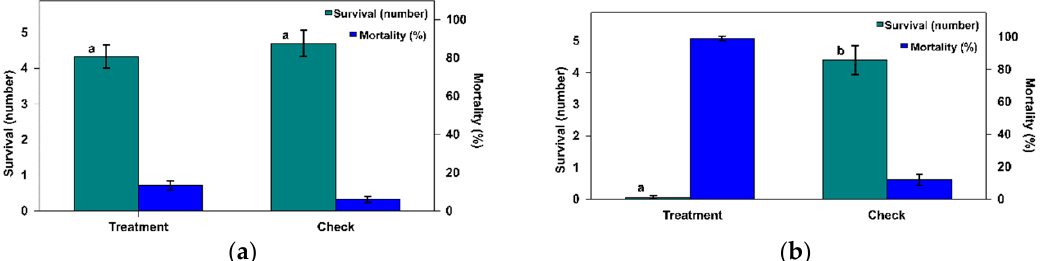
Figure 1. Number (±SE) of survivors and the mortality rate of Phthorimaea operculella eggs when exposed for 48 hours to an adult female mite of ( a ) Macrocheles robustulus or ( b ) Blattisocius tarsalis compared to the check, in the acceptance of prey assay test under laboratory conditions (values with different letters mean significant differences at p = 0.05).